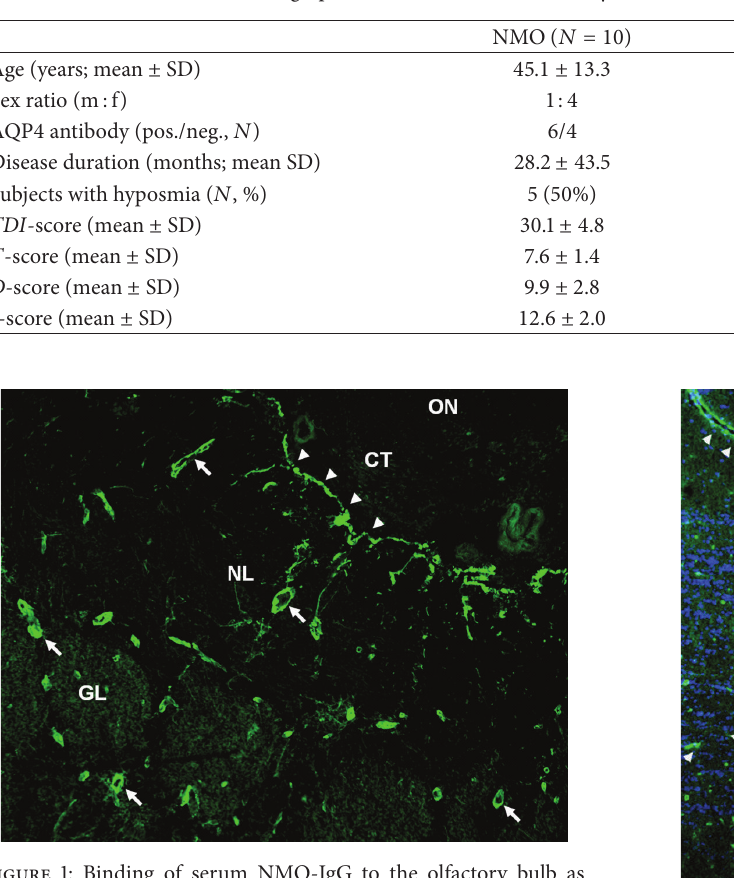
Table 1: Demographic data and means of olfactory test results in NMO patients and healthy controls.